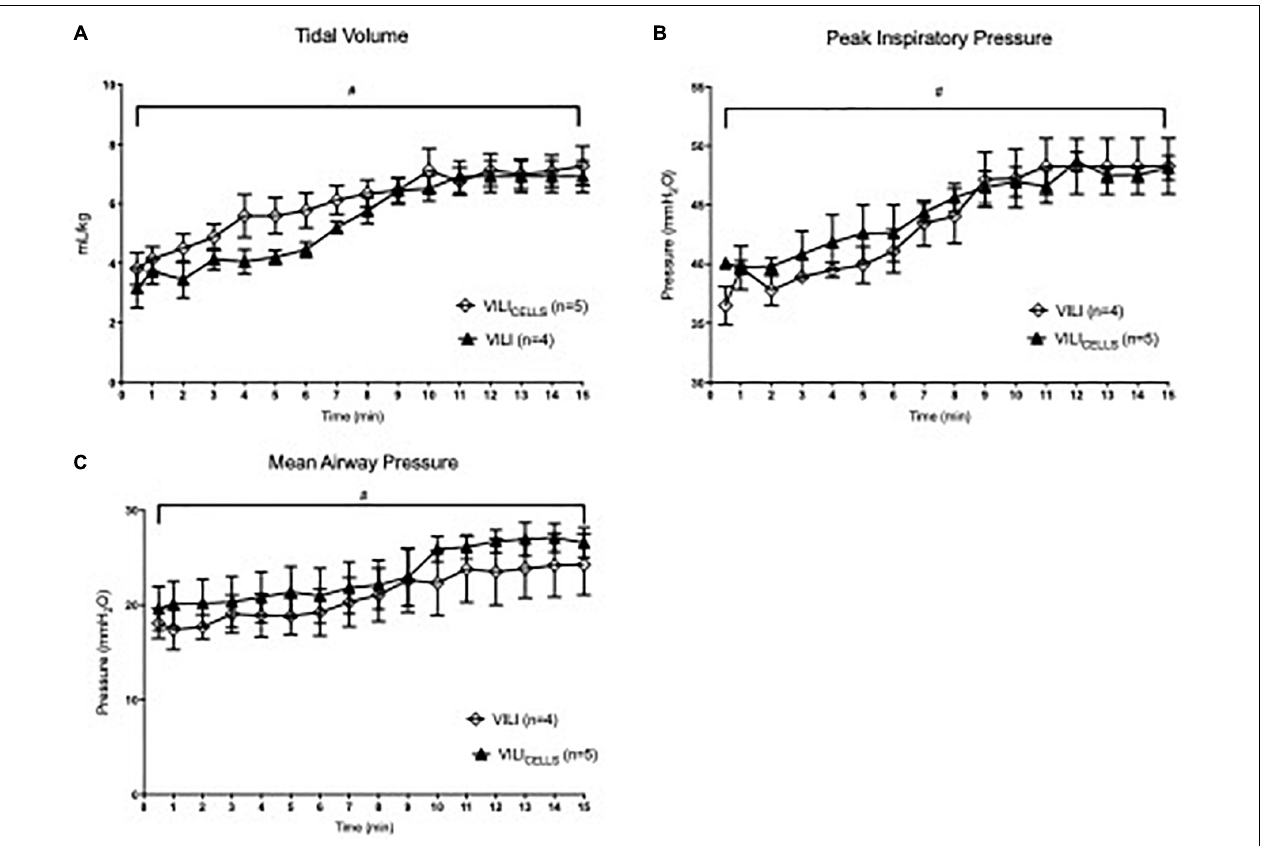
FIGURE 1 | Ventilation parameters for the two ventilated groups; VILI and VILI CELLS . (A) Tidal volume, (B) peak inspiratory pressure, and (C) mean airway pressure. # indicates that time had a significant effect on the given ventilation parameter ( # p < 0.05).